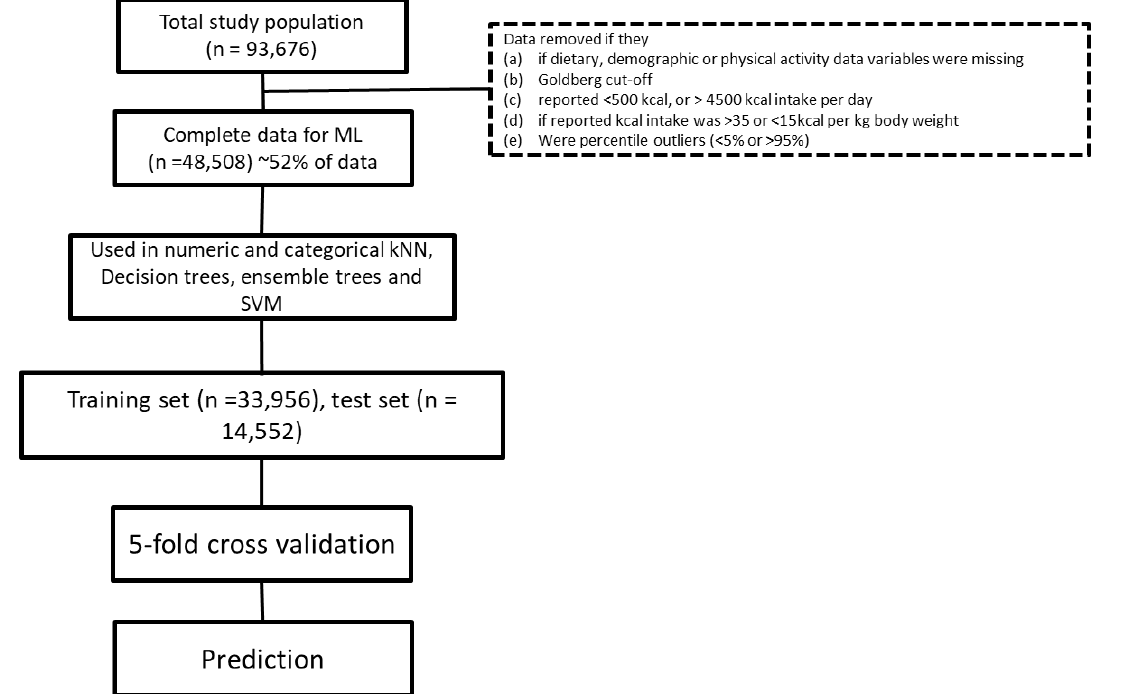
Figure 1. Flow chart presenting the data cleaning and preparation process, including the machine learning (ML) algorithms applied. kNN—k-nearest neighbors, SVM—support vector